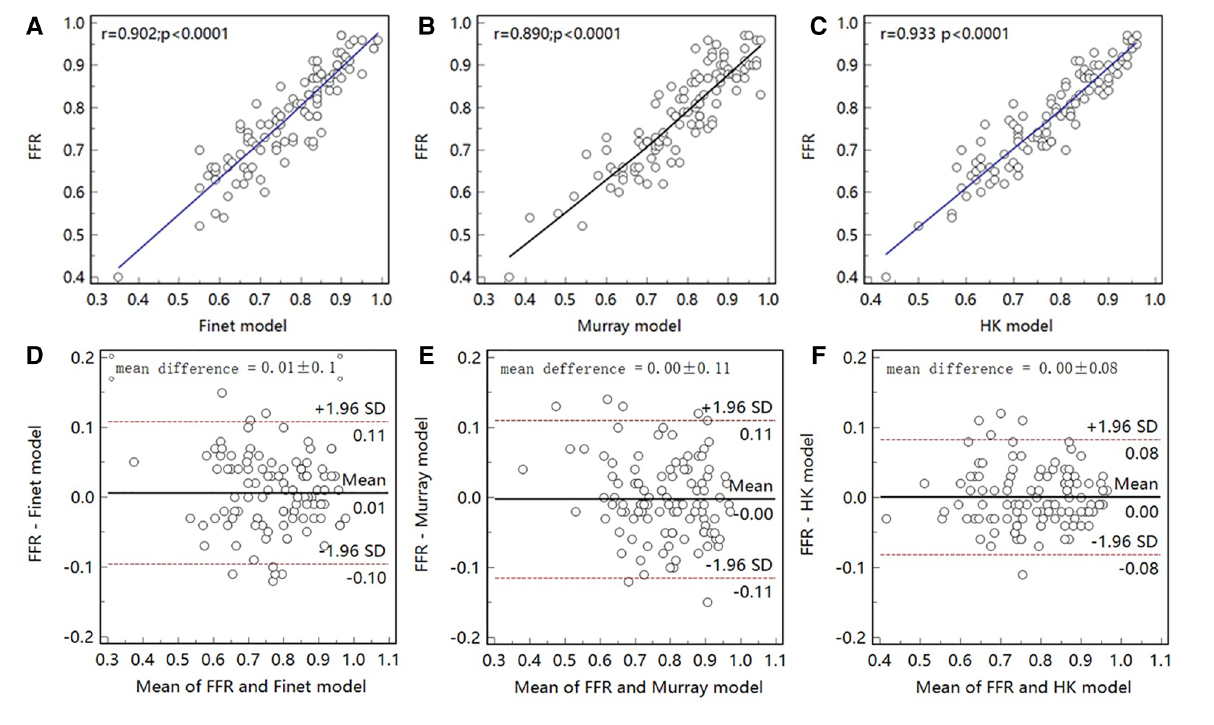
FIGURE 10 Correlation and agreement between Finet model/Murray model/HK model and invasive FFR. ( A – C ), The correlation between HK model and invasive FFR ( r ¼ 0 : 933) was higher than that between Finet model ( r ¼ 0 : 902) and Murray model ( r ¼ 0 : 890). ( D – F ) The HK model has the highest agreement with invasive